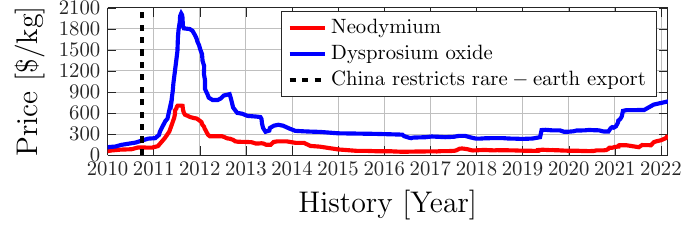
Figure 1. Historical rare-earth material prices.